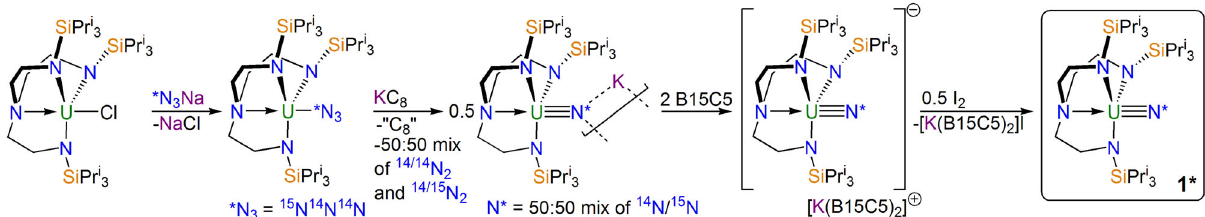
Fig. 1 Multi-step synthesis of 1*. The initial chloride complex is converted to the corresponding azide by salt elimination. Reduction releases N 2 to produce a bridging nitride dimer, which can be cleaved into a separated ion pair by treatment with the appropriate crown ether. Oxidation of the separated ion pair gives neutral, 50% 15 N-labelled 1* for the NMR investigations described in this study. B15C5 = benzo-15-crown-5